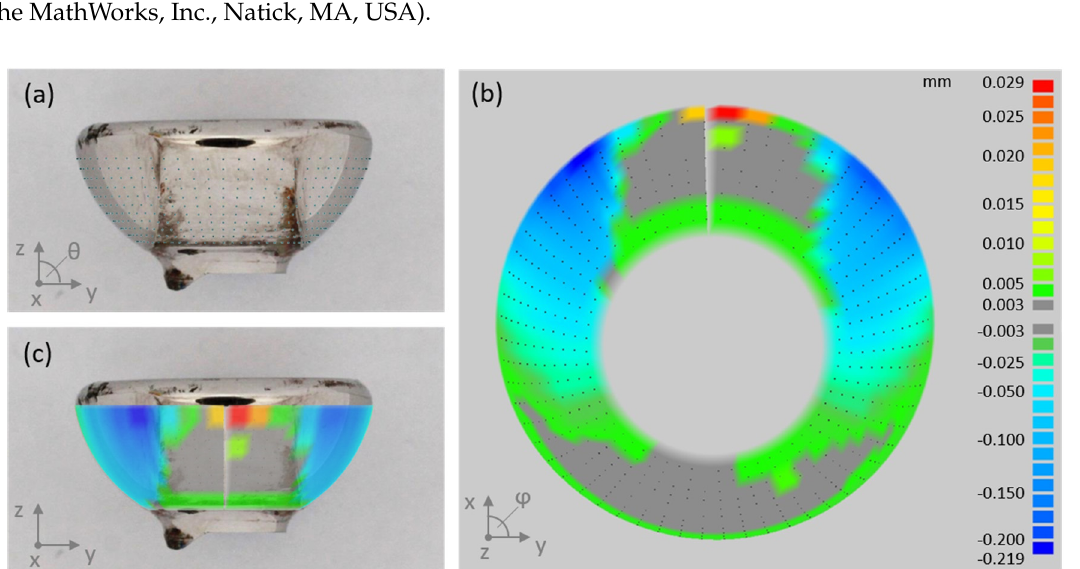
Figure 3. ( a ) Piston head (cut from the piston stem) with point cloud measured by CMM. ( b ) Color plot of linear wear, i.e., normal deviation between measured data and referencing surface. Gray areas refer to linear wear < 3 µm, which can be considered as unworn. ( c ) Overlay of linear wear plot and piston head image illustrates the unworn and most heavily abraded areas, respectively.